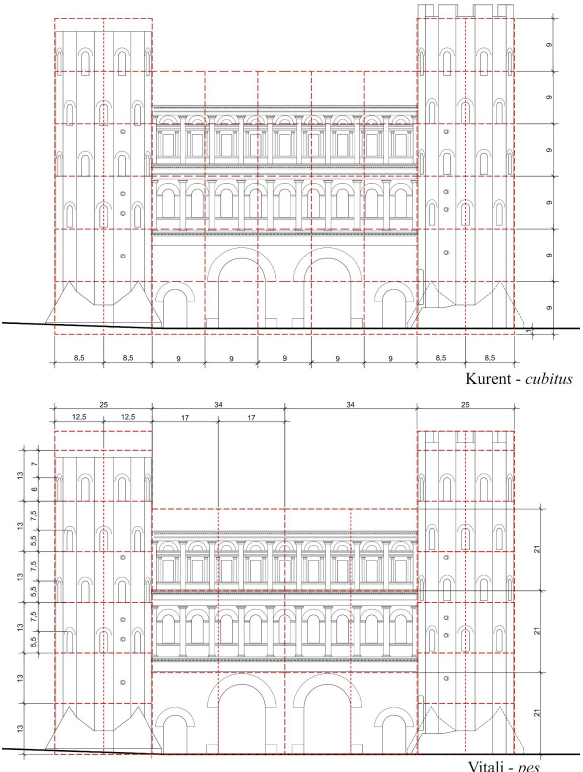
Figure 7 . In scale drawing of the north elevation of the Porta Palatina © M. Vitali